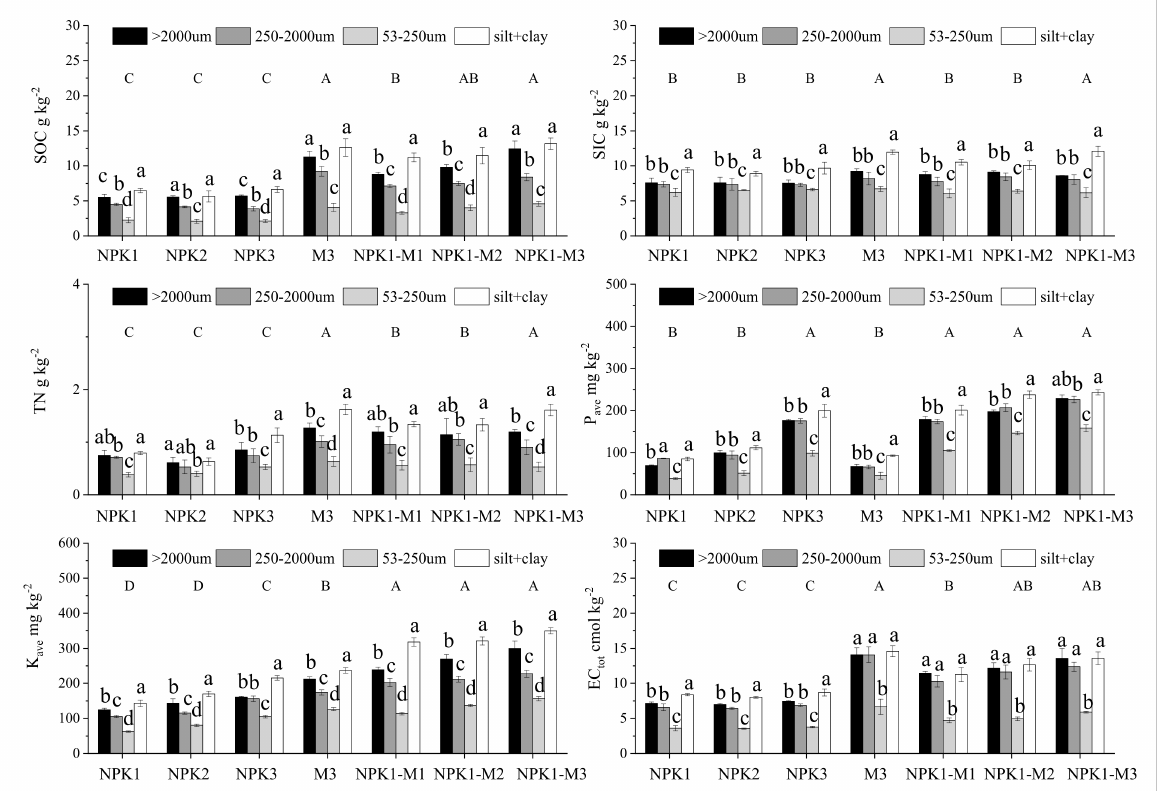
Figure 2. The effect of long-term fertilization on the SOC, SIC, TN, P ave , K ave and EC tot content of aggregate fractions. Bars represent the mean + standard error ( n = 3). Different letters indicate significant differences among the treatments ( p <